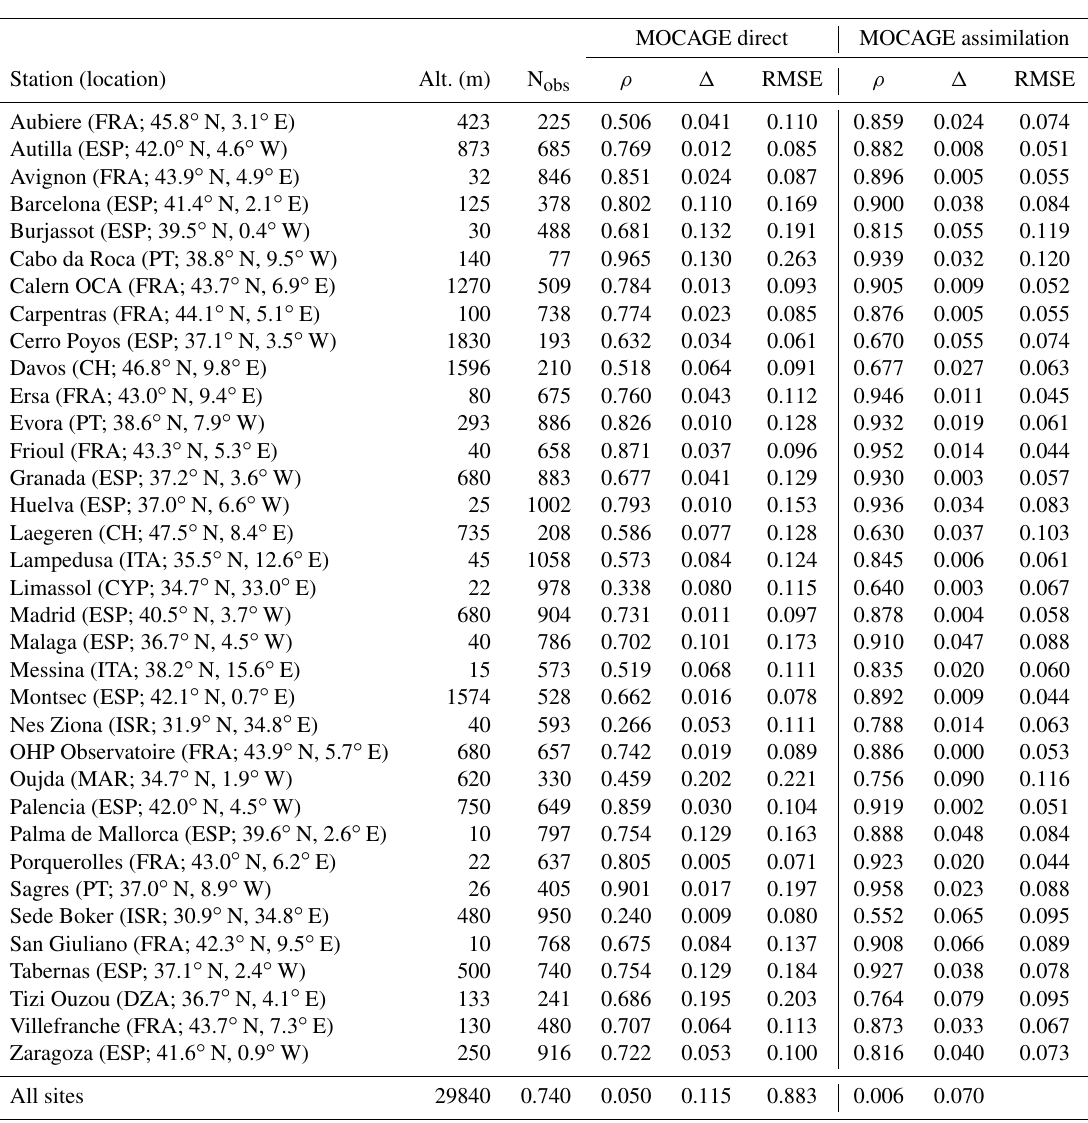
Table 3. Correlation ( ρ ), absolute bias ( (cid:49) ) and root mean square error (RMSE) between AERONET observations and MOCAGE di- rect/assimilation run for the period of the TRAQA campaign between 25 June and 13 July 2012. Each of the stations in the table is identified by its site name, latitude/longitude, station height, number of observations and above-mentioned statistical parameters. AERONET site locations are also presented in Fig.